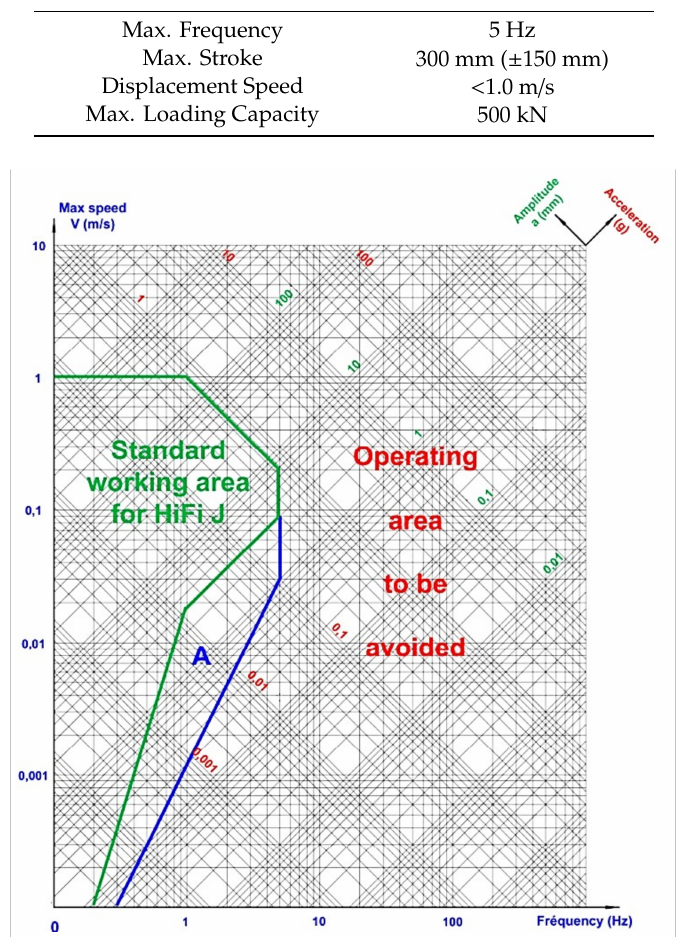
Figure 12. Operational diagram of the